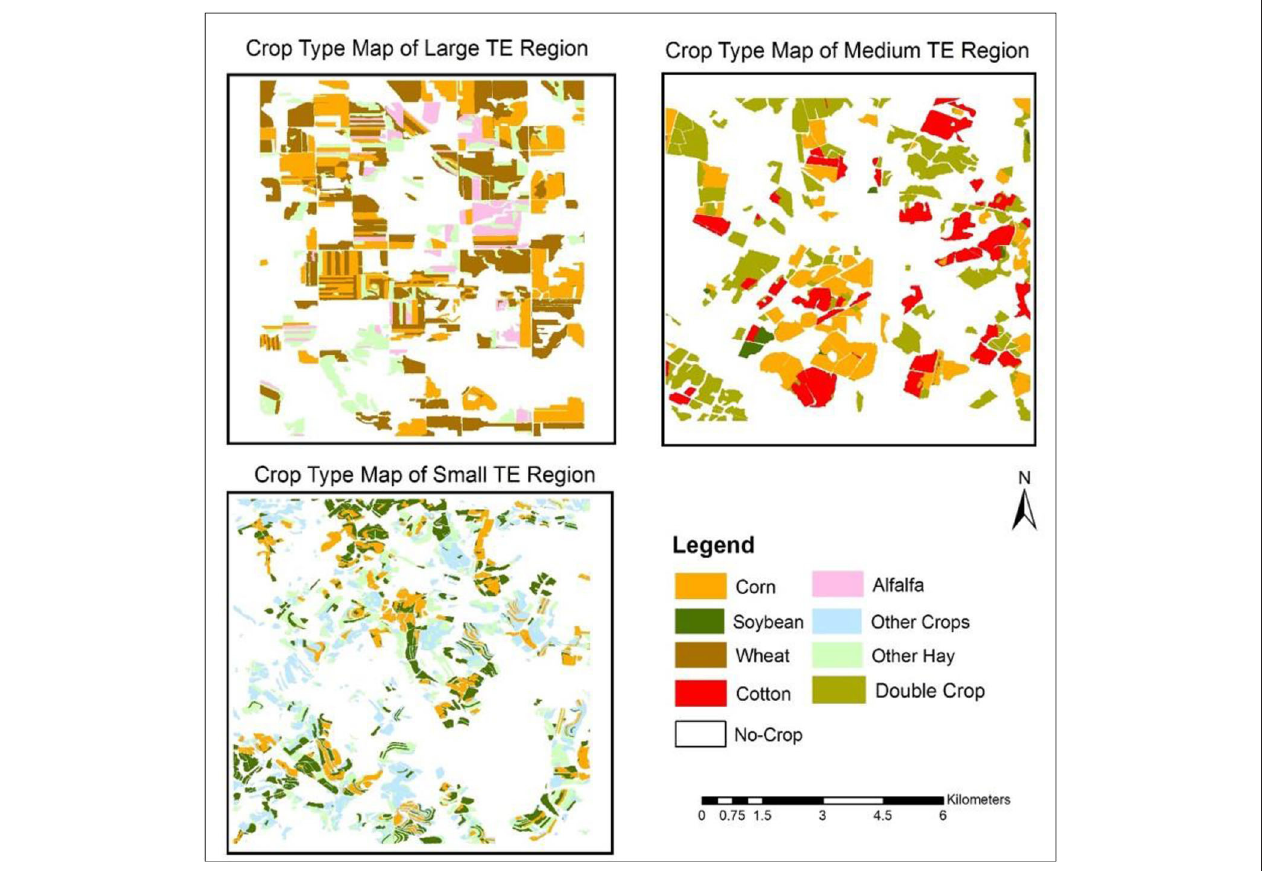
FIGURE 8 | The crop type maps of the three TE regions produced from the classification of multi-dates of satellite imagery in large, medium, and small field sizes.